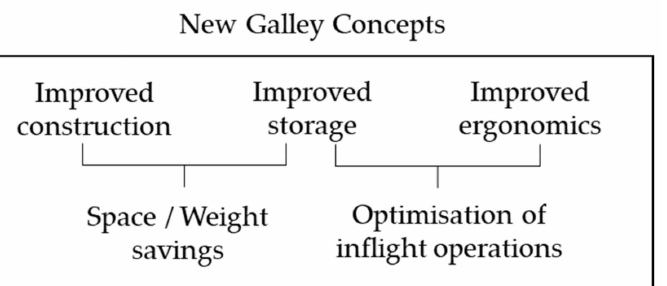
Figure 2. Main approaches for new galley